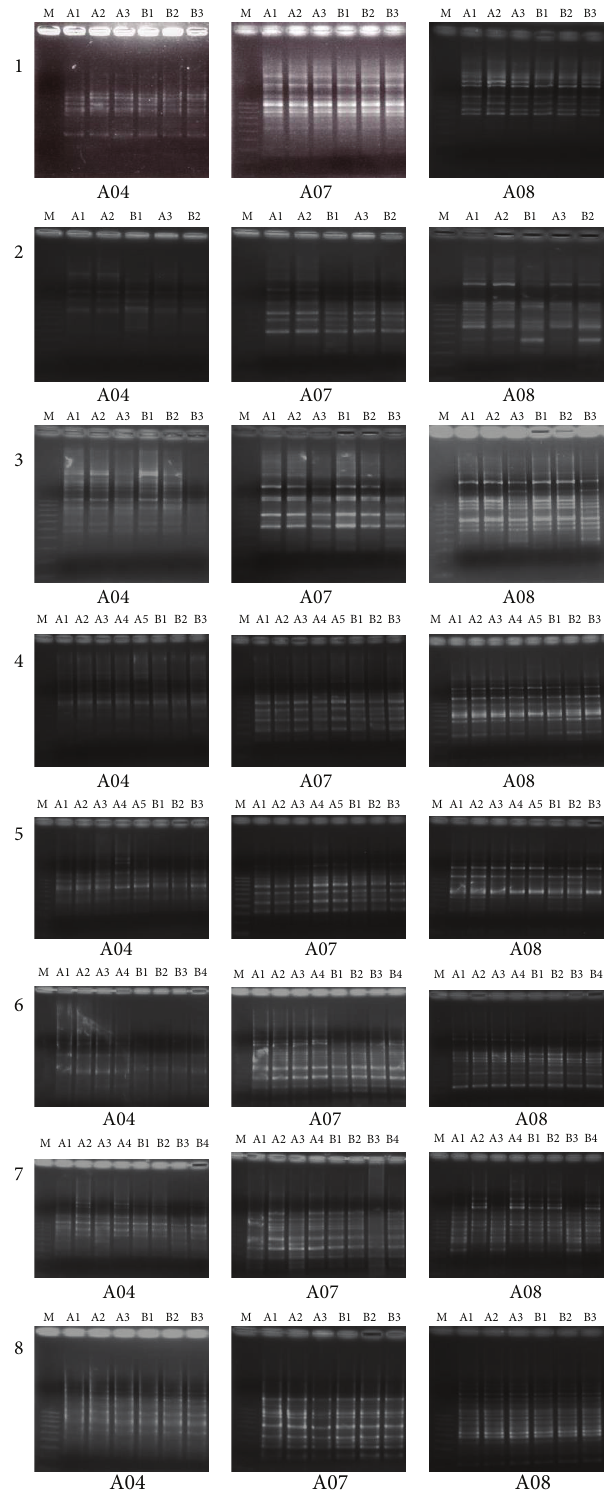
Figure 2: RAPD fingerprint patterns of genomic DNAs from H. pylori isolates from eight patients (No. 1–8) obtained by RAPD analysis with primers A04, A07, A08, and A11. DNA samples were obtained from the antrum (A series) and corpus (B series). No. 4 and 5 are members of the same family. Data for primer A11 are not shown. A 100bp DNA ladder was used as a size marker (lane